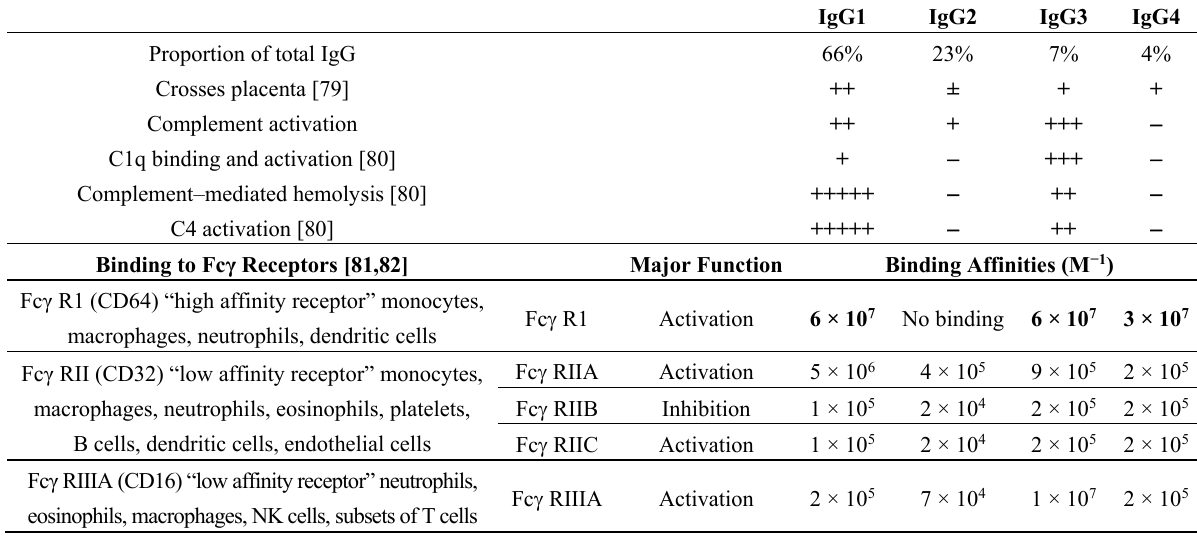
Table 2. Properties of human IgG